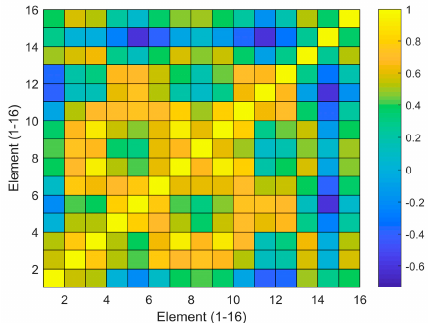
Figure 19. Correlation coefficients of signal.